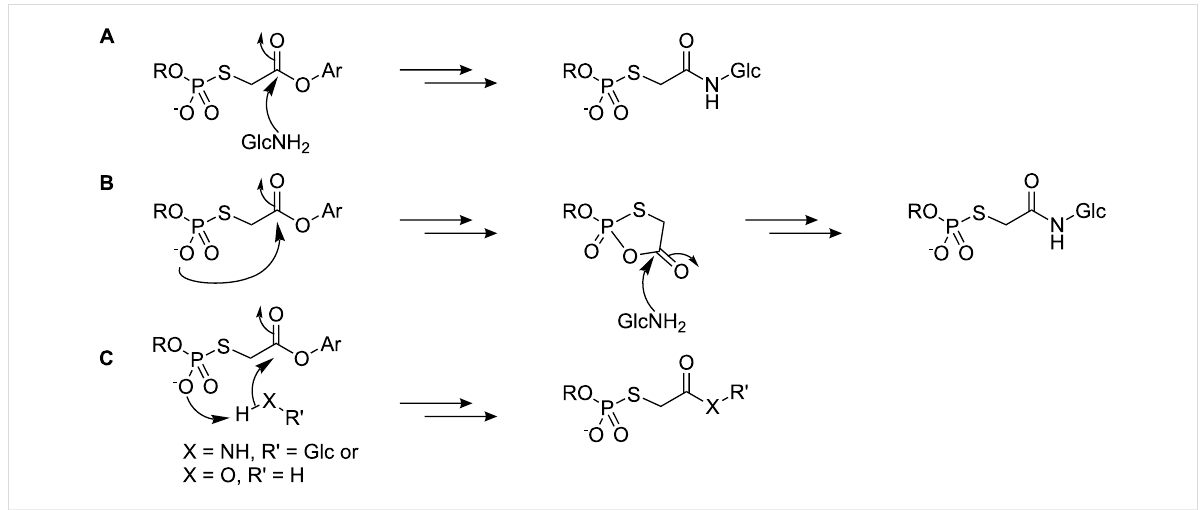
Scheme 6: (A) Direct aminolysis of the ester carbonyl group; (B) intramolecular nucleophilic catalysis of ester cleavage followed by aminolysis of the mixed phosphoric-carboxylic anhydride; (C) intramolecular general base-assisted attack by amine or water.